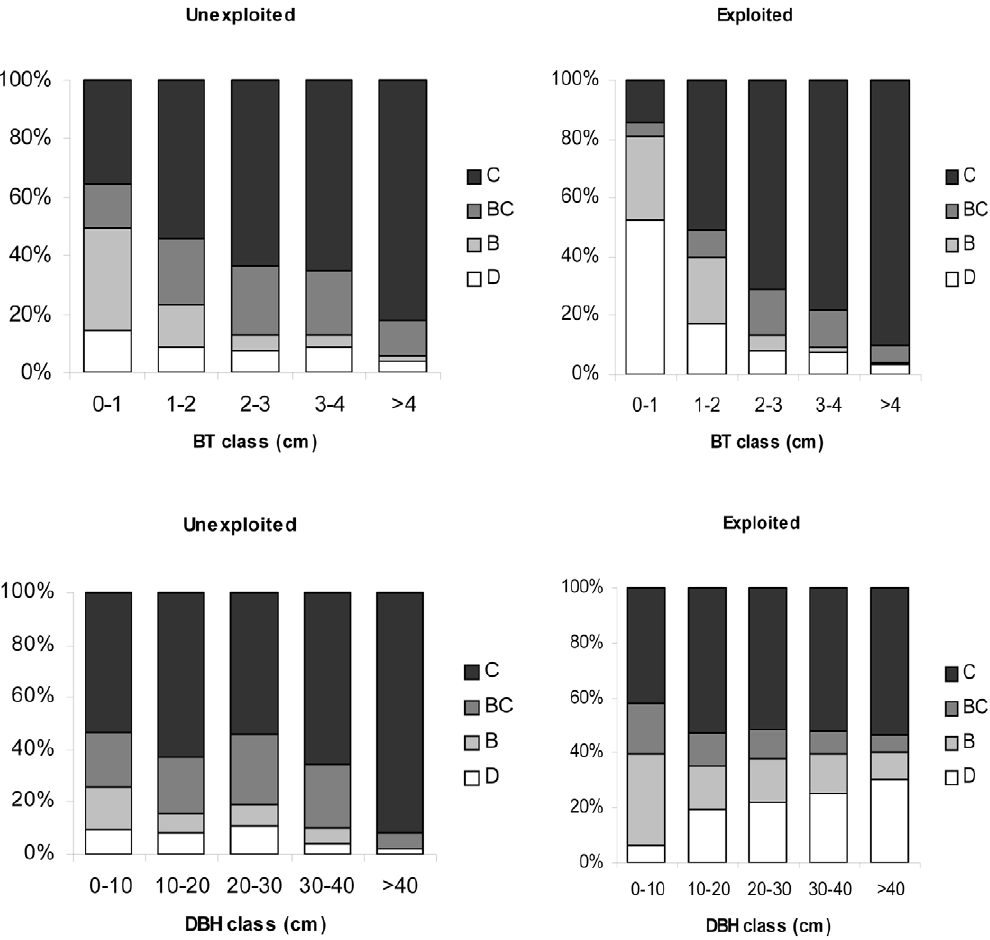
Figure 2. Post-fire Q.suber responses. Observed post-fire tree responses (D – dead, B – basal resprouting only, BC – basal and crown resprouting, C – crown resprouting only) as a function of bark exploitation status (exploited, unexploited), bark thickness (BT; figures above) and tree diameter (DBH; figures below). The number of individuals in each class is indicated in the top of the respective bar.